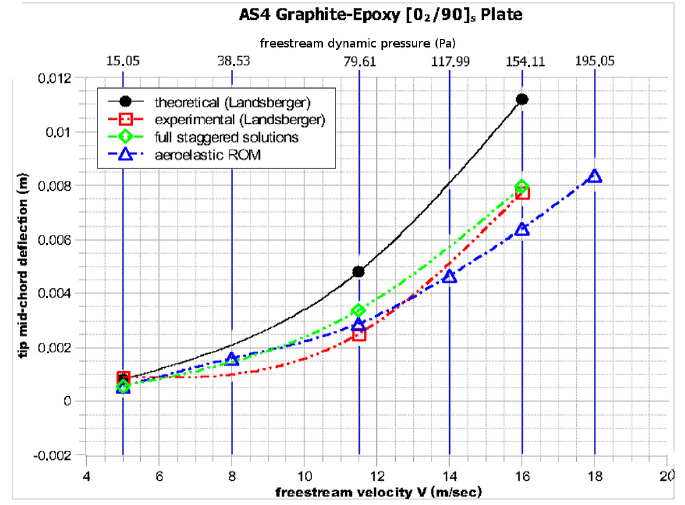
Figure 7. Tip mid-chord static aeroelastic deflection for the [ 0 2 /90 ] s plate